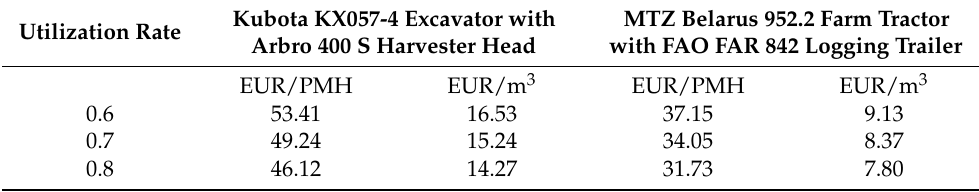
Table 10. Expected net costs as a function of utilization